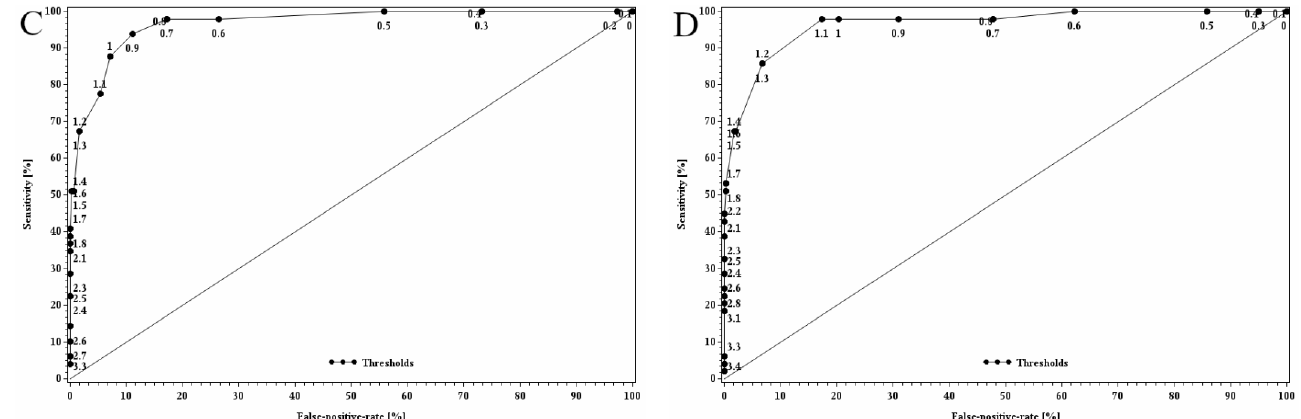
Figure 4. Analysis of receiver operating characteristics curve for four handheld devices (TD 1 ( A ), GLP 1 ( B ), WVB 1 ( C ), FSP 1 ( D )) measuring BHBA concentrations in the blood for the diagnosis of subclinical ketosis using ≥ 1.4 mmol/L as